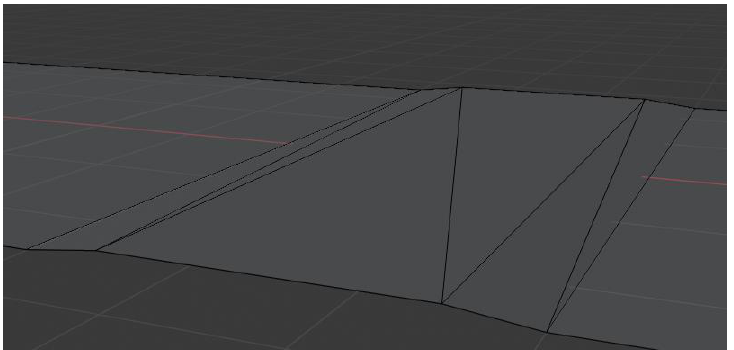
Figure 19. Speed bump B after triangularization.